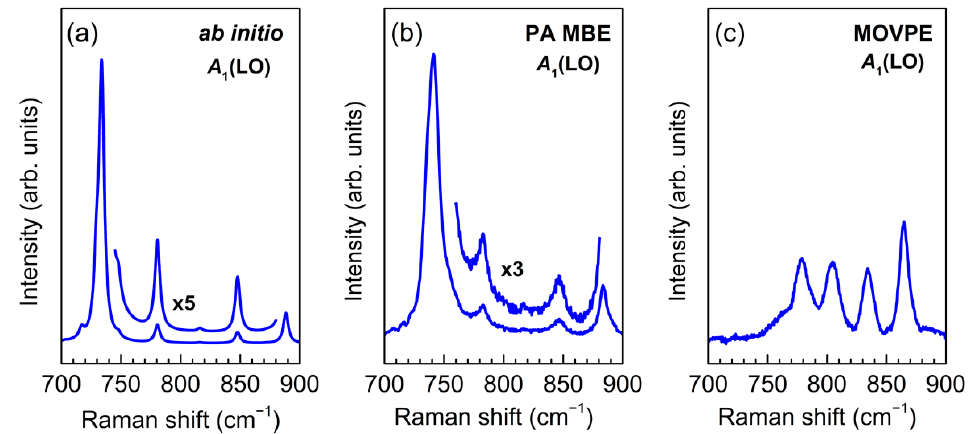
Figure 2. Ab initio simulated ( a ) and experimental ( b , c ) z ( xx ) z Raman spectra of (GaN) 6 /(AlN) 6 SLs in the range of A 1 (LO) modes. The SLs were grown by PA MBE ( b ) and MOVPE ( c ). In order to verify this hypothesis, we simulated the Raman spectra of SLs with diffuse interfaces. The diffusion of sharp interfaces in binary SLs implies the presence of regions, in which cation sites in each atomic plane perpendicular to the growth axis are randomly occupied by Ga and Al atoms, whereas their relative concentration Ga/Al is assumed to change linearly within the interface layer from 1/0 to 0/1 (and vice versa ). Modeling the